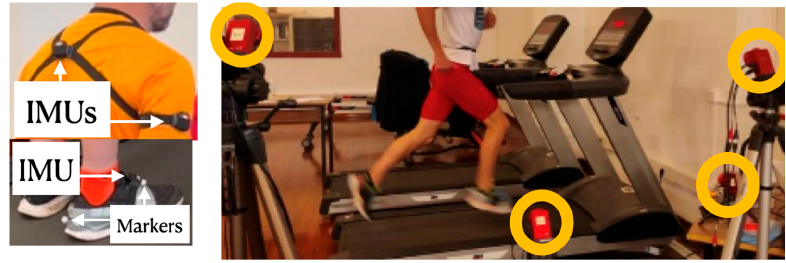
Figure 4. ( Left ): positioning of the IMUs, and the reflective markers for the optical MOCAP system, over the body of the athlete. ( Right ): Optitrack camera disposition. Three Flex 3 Optitrack (Figure 4, right) cameras were positioned so that the markers on the athlete’s right foot were always visible. Reflective markers were placed on the heel